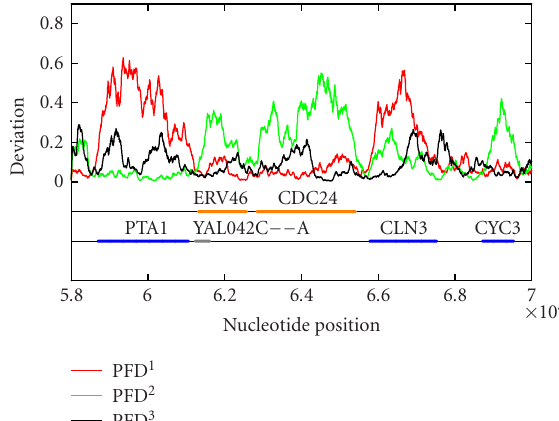
Figure 5. The reading-frame-specific PFD i , i = 1 , 2 , 3 curves for a segment of DNA in yeast chromosome I (from nucleotide 58000 to nucleotide 70000). The sliding window size is w = 512. A 5th-order moving average filter has been applied. Colored horizontal bars on the two lines below the deviation curves are the open reading frames on the two strands of the chromosome, (first line: positive strand; second line: reverse strand). The orange and blue bars represent verified ORFs while a gray bar represents a dubious ORF.